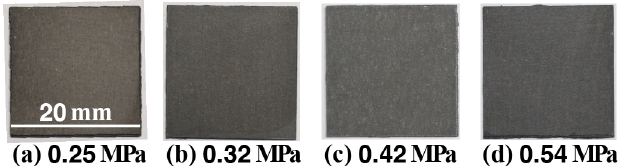
Figure 2. Appearances of the films formed on AZ61 by steam coating under different treatment conditions.